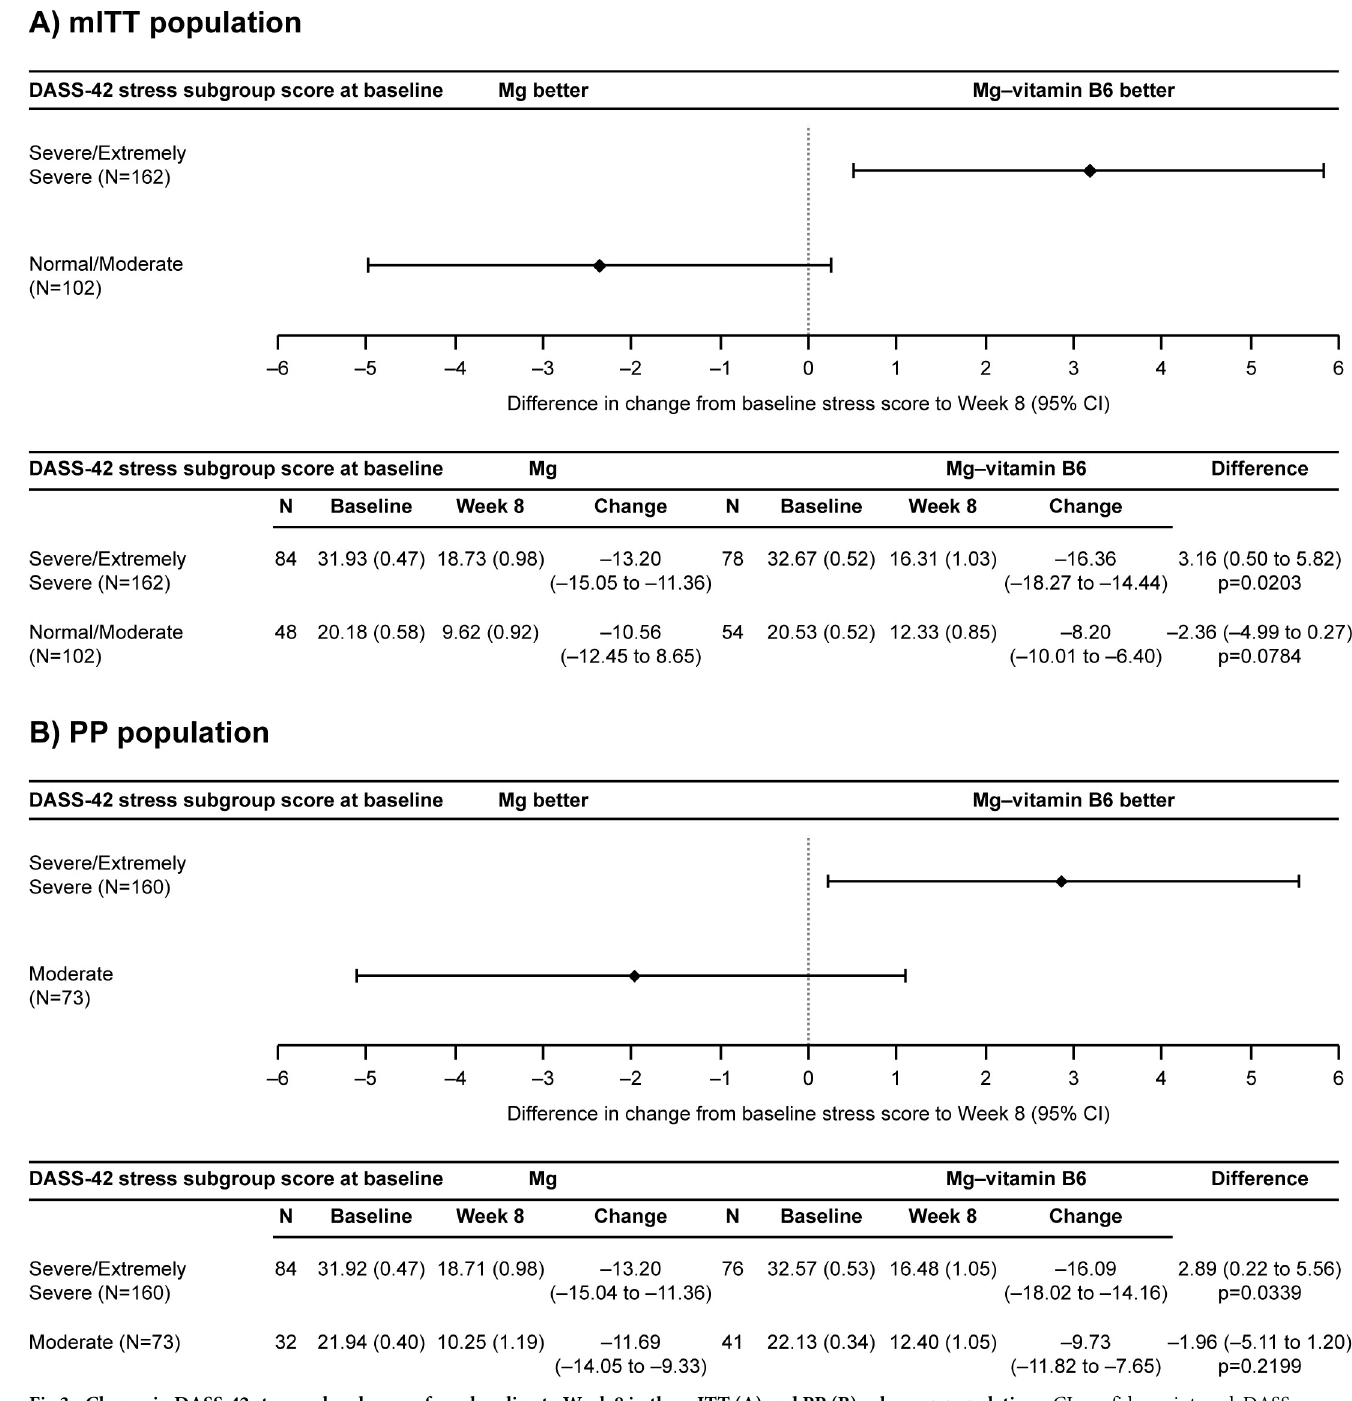
Fig 3. Change in DASS-42 stress subscale score from baseline to Week 8 in the mITT (A) and PP (B) subgroup populations. CI, confidence interval; DASS, Depression Anxiety Stress Scale; Mg, magnesium; mITT, modified intention-to-treat; PP, per protocol; Vit B6, vitamin B6.